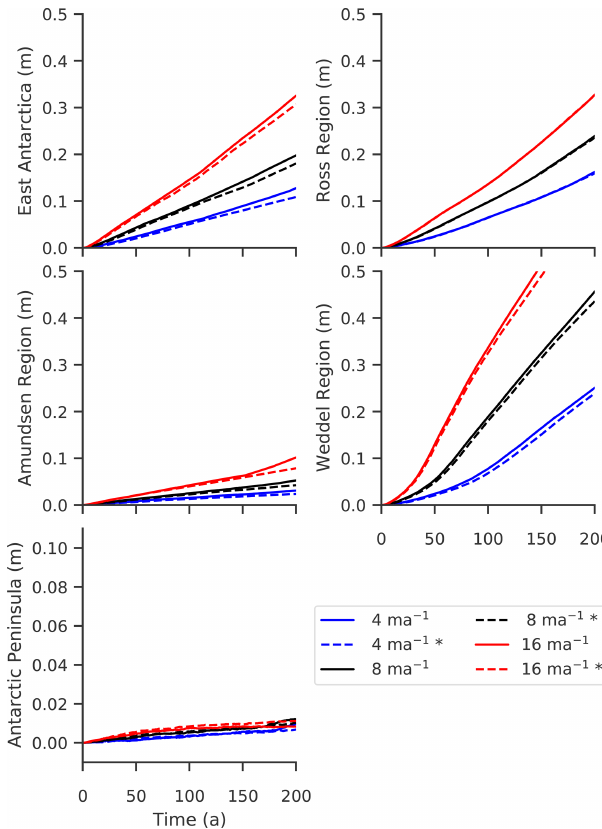
Figure 3. Mass loss of the different regions in Antarctica (indicated on the y axis) driven by constant LARMIP-2 basal melt rate forc- ing. For the experiments from the LARMIP-2 protocol we show the changes in volume above flotation initialized from a historic simu- lation (solid line) and from the initial state directly (dashed line, in- dicated by ∗ ). Mass loss is shown relative to the respective control simulation. From the response of the ice sheet to a constant melt rate forcing over 200 years, a response function is derived which then serves to emulate the sea level contribution under various cli- mate scenarios. This figure is similar to Fig. 4 in Levermann et al.